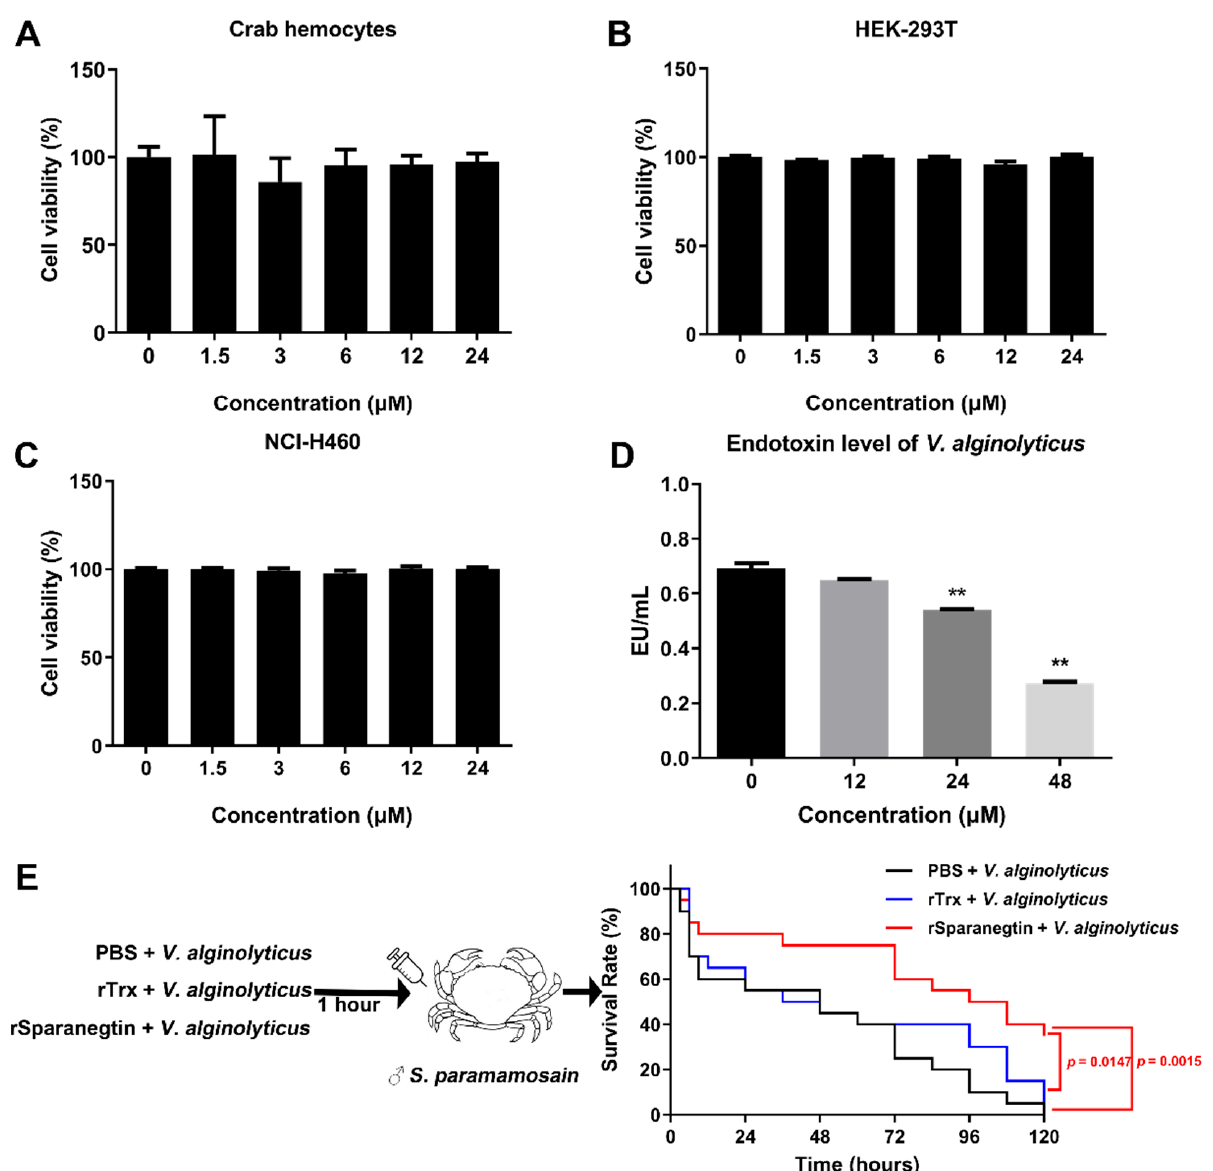
Figure 4. In vivo protective effect of rSparanegtin on V. alginolyticus -infected S. paramamosain. The cytotoxic effect of rSparanegtin on crab hemocytes ( A ), HEK-293T ( B ), and NCI-H460 ( C ) was determined by the MTS method; data are presented as mean ± standard deviation (SD) ( n = 3). **: p < 0.01, one-way analysis of variance (ANOVA) and Dunnett post-test. Endotoxin level of V. alginolyticus after rSparanegtin treatment in vitro ( D ). In vivo protective effect of rSparanegti was evaluated ( E ). The rSparanegtin (20 µ g/crab), rTrx (20 µ g/crab), and PBS was incubated with V. alginolyticus (1 × 10 6 CFU/crab) at room temperature for 60 min and then injected into the male crabs ( n = 20 for each group). The survival curves were analyzed using the Kaplan–Meier Log rank test.